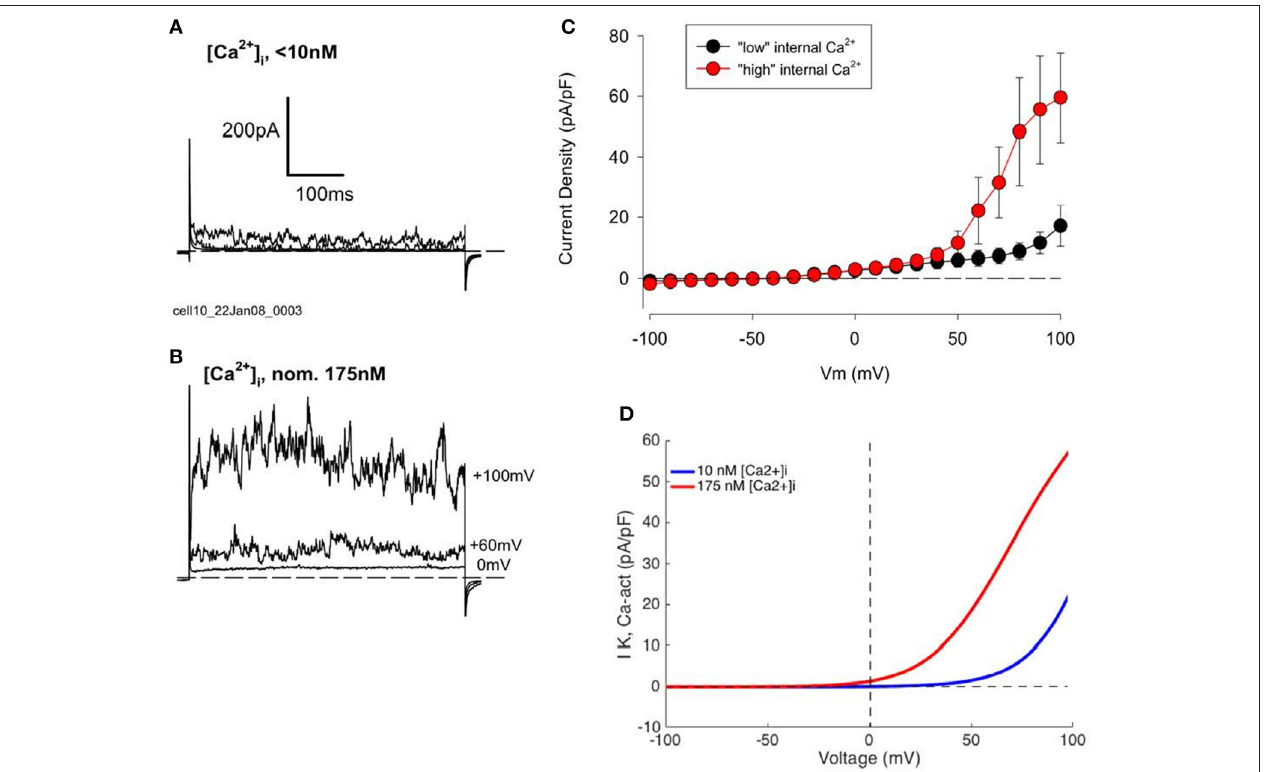
FIGURE 4 | Effect of changes in intracellular Ca 2 + , [Ca 2 + ] i , concentration on K + currents in human articular chondrocytes. (A) Example of currents from a HAC with “low” internal [Ca 2 + ] i (0 [Ca 2 + ] i , 10mM EGTA). Currents produced by voltage steps to 0, C m 9.72 pF. (B) Currents from a cell with “high” internal [Ca 2 + ] i (3mM added Ca 2 + , 10mM EGTA; nominal Ca 2 + concentration = were to 0, 60, and 100mV. C m 6.24 pF. Currents in (A,B) were not leak or capacity current corrected. (C) I–V relations for groups of HAC with “low” (n + + = blue) and “high” (n 4, red) [Ca 2 + ] i patch-clamp solution. These chondrocytes were all from same batch, 1 day in culture. (D) Model I–Vs for I K = internal [Ca 2 + ] levels (from Equation